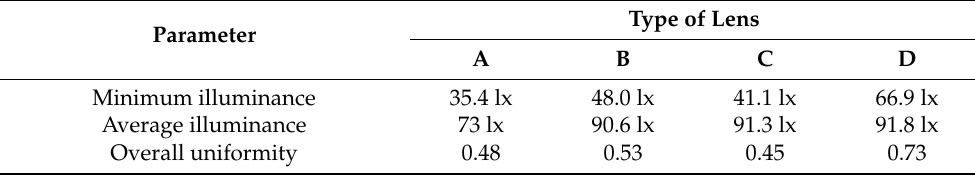
Table 2. Illuminance simulation results of LED seaport lighting using each type of lens.